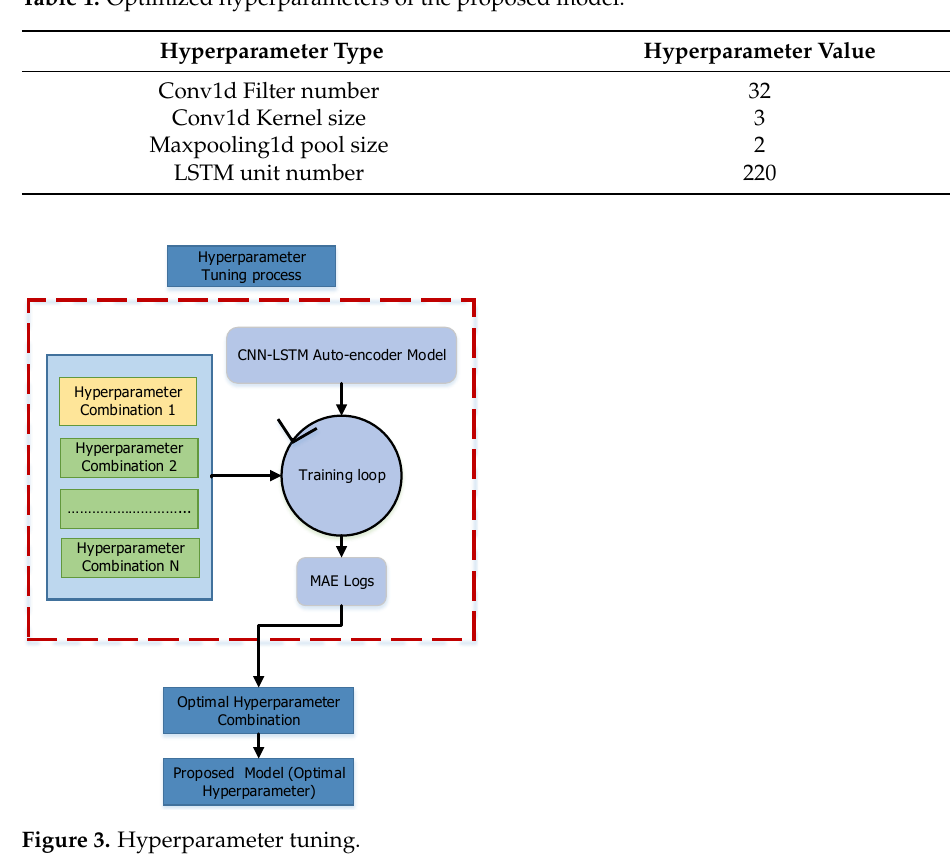
Table 1. Optimized hyperparameters of the proposed model.